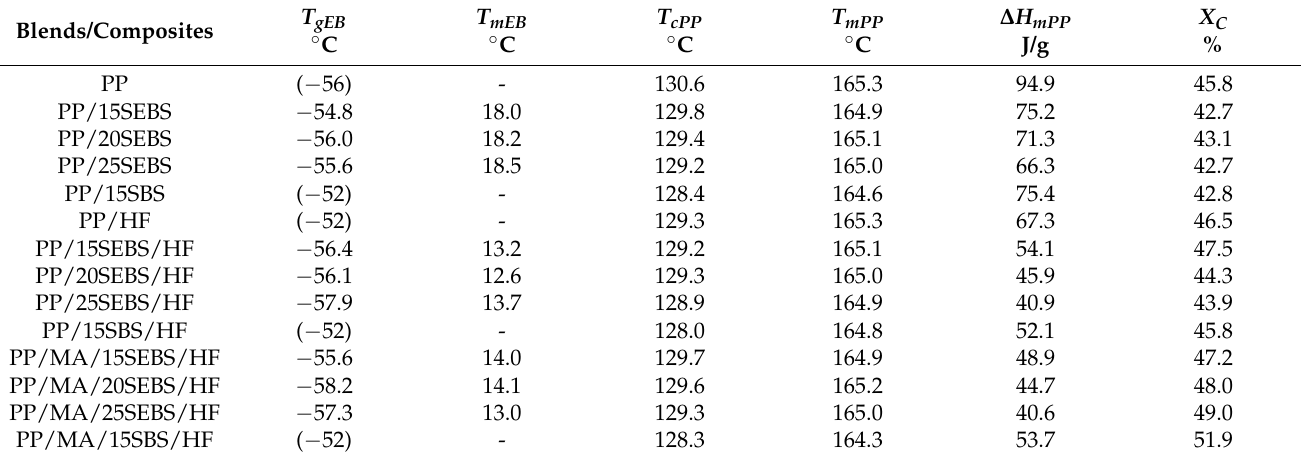
Figure 8. DSC curves of the composites: second melting cycle ( a ), cooling cycle ( b ), second melting cycle (SEBS temperature domain) ( c ), and cooling cycle (SEBS temperature domain) ( d ).